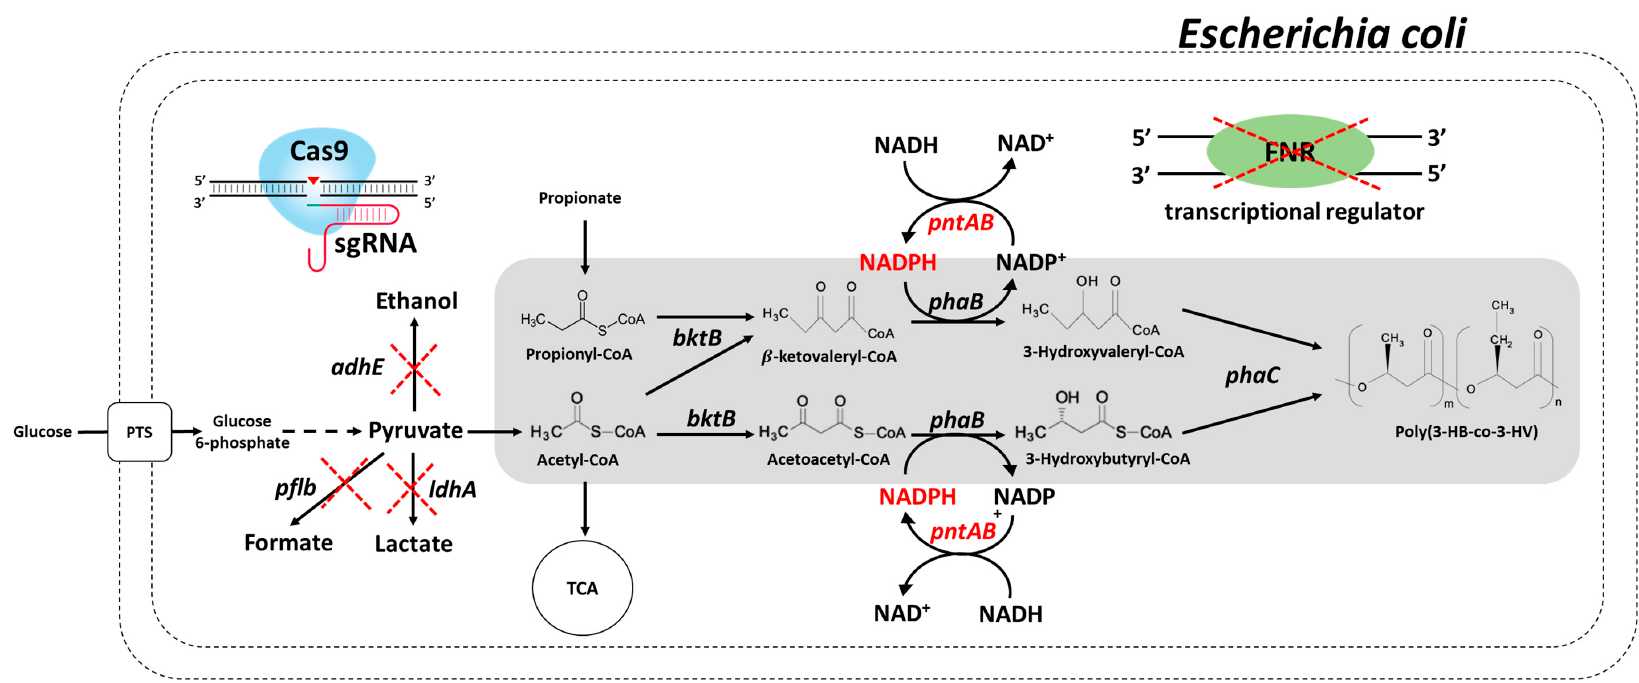
Figure 1. Polyhydroxyalkanoate production in engineered E. coli . Engineered metabolic pathways for production of polyhydroxyalkanoate in recombinant E. coli . Genes involved in metabolic engineering and polyhydroxyalkanoate production pathway are shown. Pflb, pyruvate formate lyase; LdhA, D -lactate dehydrogenase; AdhE, acetaldehyde-alcohol dehydrogenase; Fnr, transcriptional regulator for expressing anaerobic metabolism; PntAB, transhydrogenase; BktB, β -ketothiolase; PhaB, acetoacetyl-CoA reductase; PhaC, polyhydroxyalkanoate synthase.